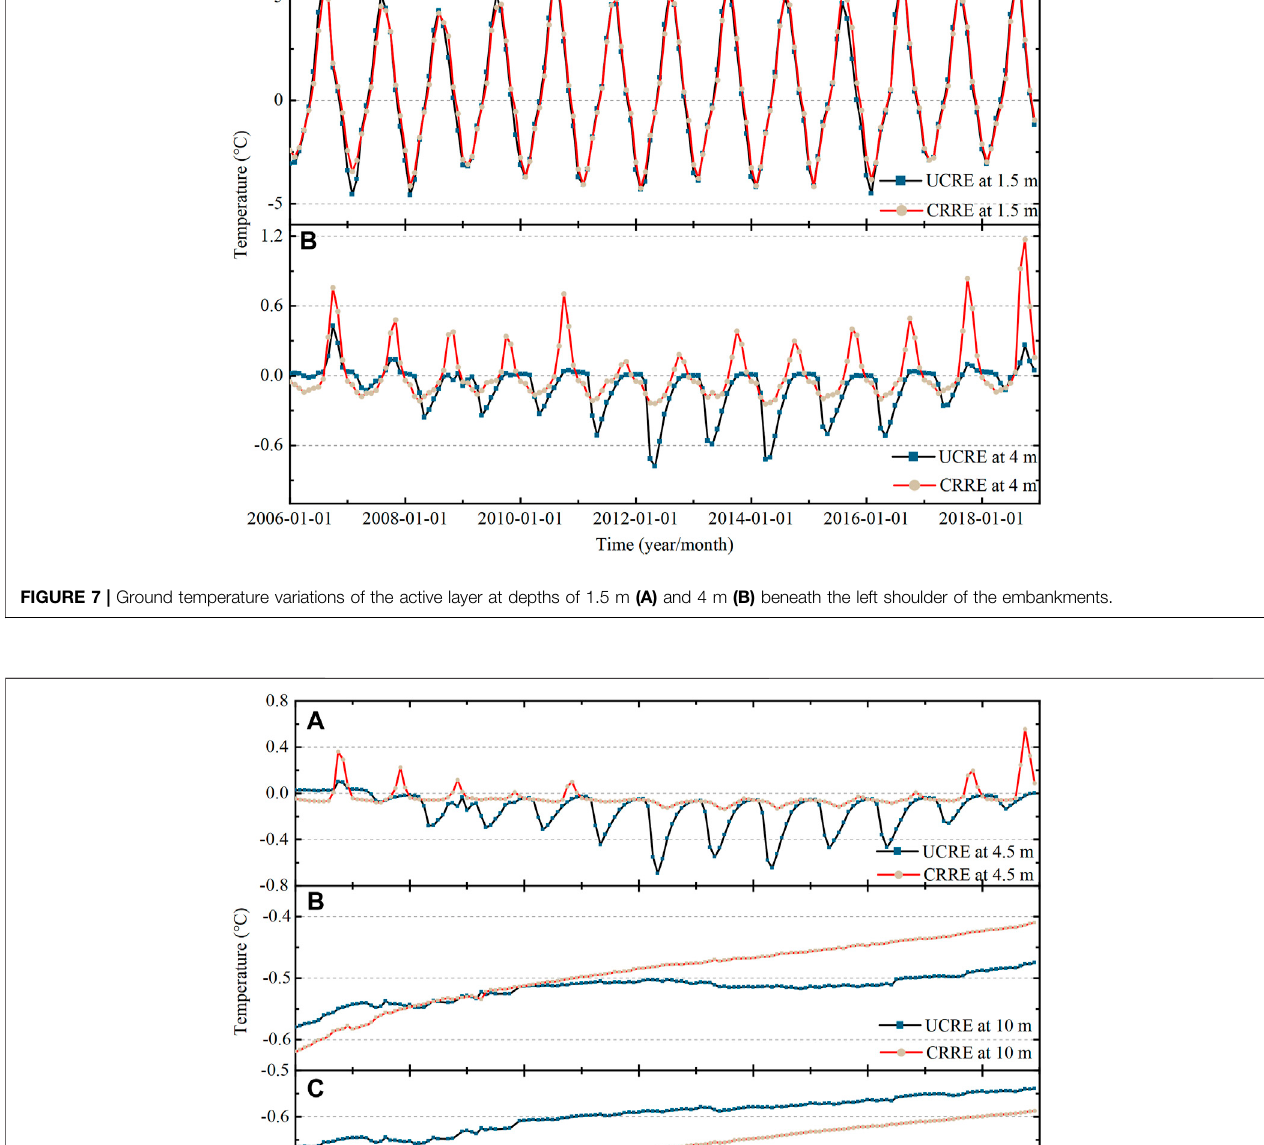
Frontiers in Earth Science |